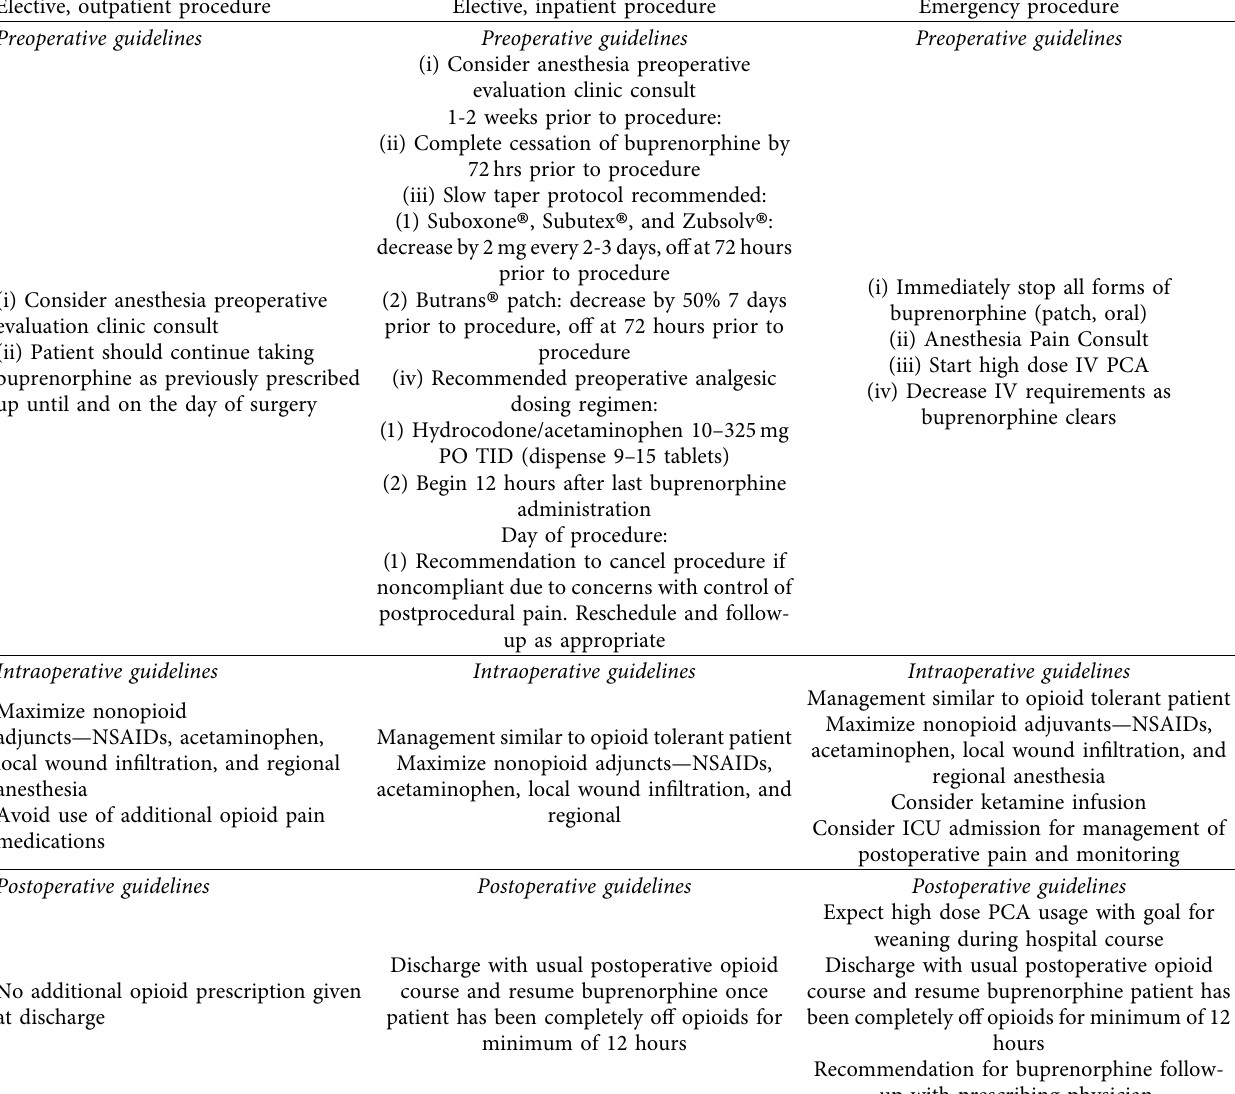
Table 2: Mayo Clinic Arizona periprocedural guidelines for patients taking buprenorphine. Elective, outpatient procedure Elective, inpatient